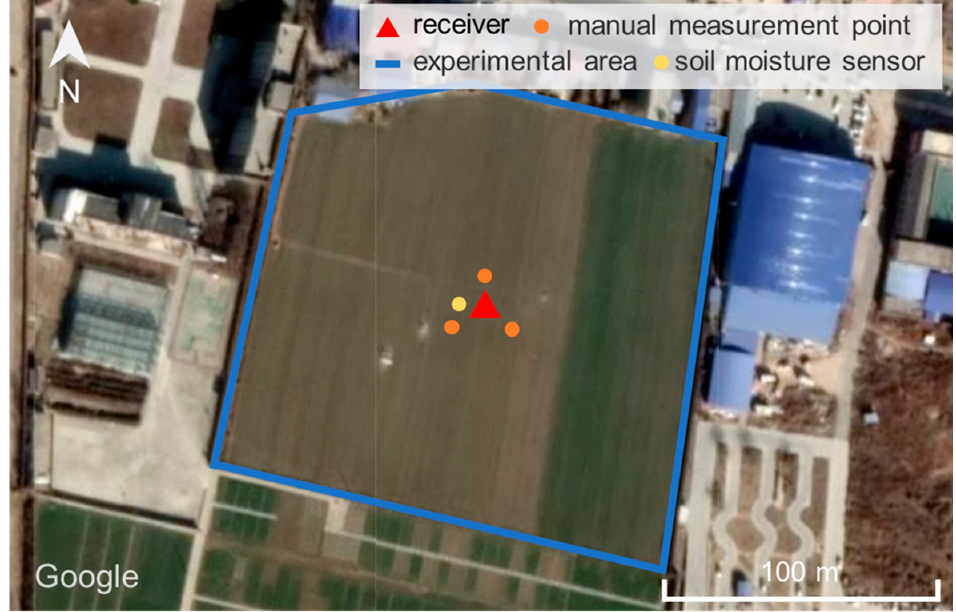
Figure 4. The experimental site. The red triangle is the location of the receiver. The area within the blue line is the experimental site. The yellow dot represents the location where the sensor is buried, and the orange-yellow dots represent the manual measurement points.